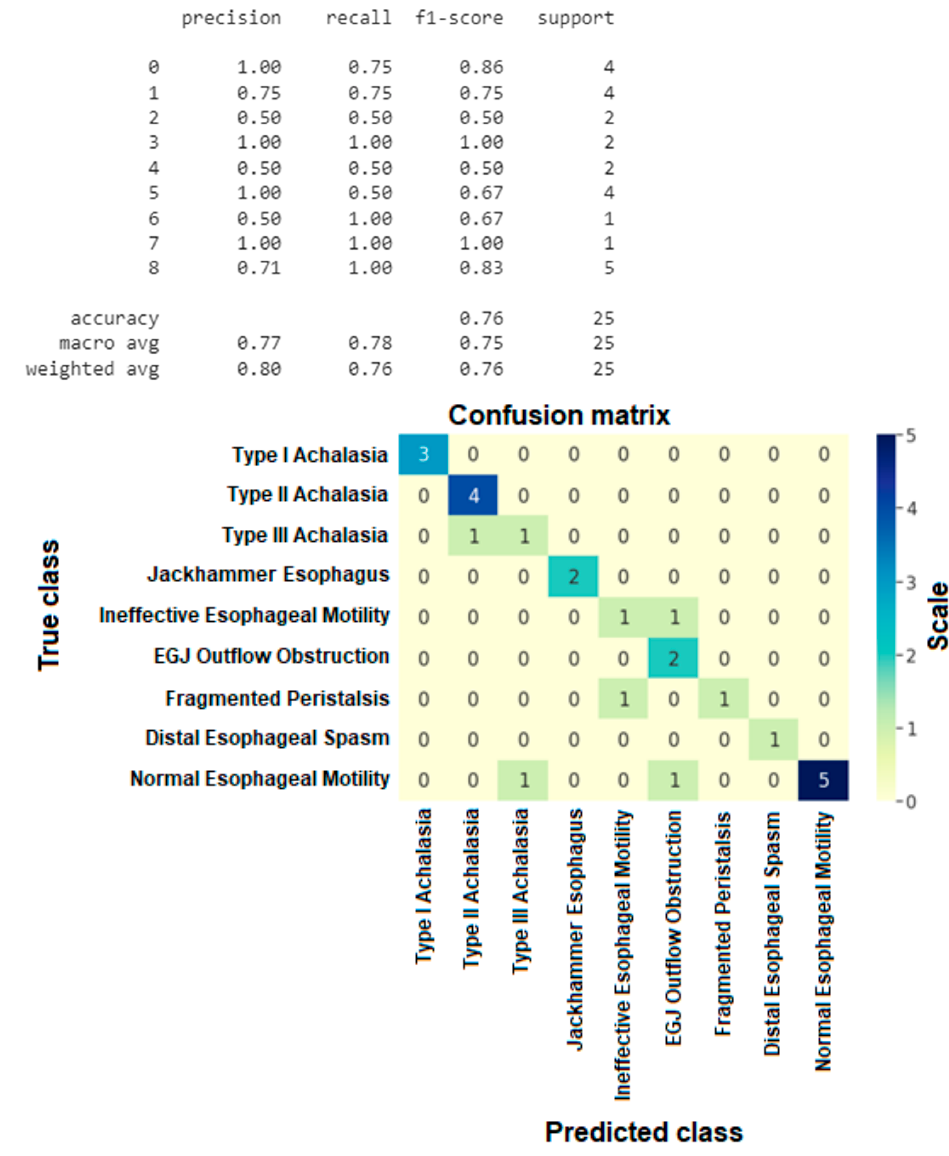
Figure 6. Swallowing pattern classification confusion matrix.